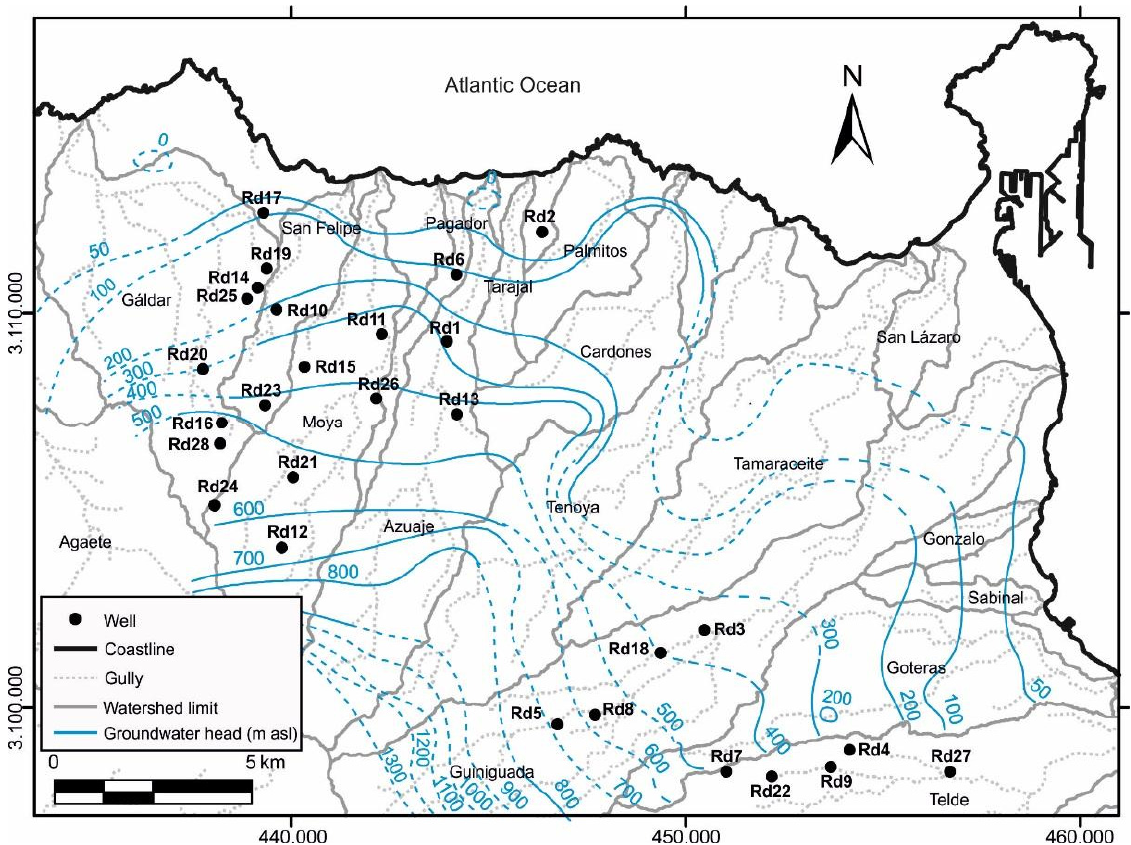
Figure 2. Spatial distribution of the groundwater sampling points and groundwater head contours 2008–2009, modified from [28,29]. The names of the gullies are indicated. Coordinates in UTM WGS84